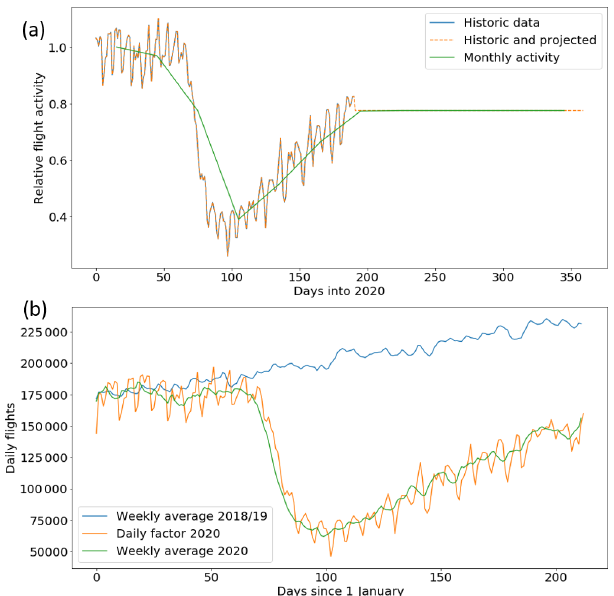
Figure 4. Aviation data for (a) monthly calculation of activity level – this is normalised to the January data, as data from previous years were not available in open-source format – and (b) workings to- wards weekly activity level, using closed-source data from previ- ous years too. This approach is used from version 5 onwards for monthly data